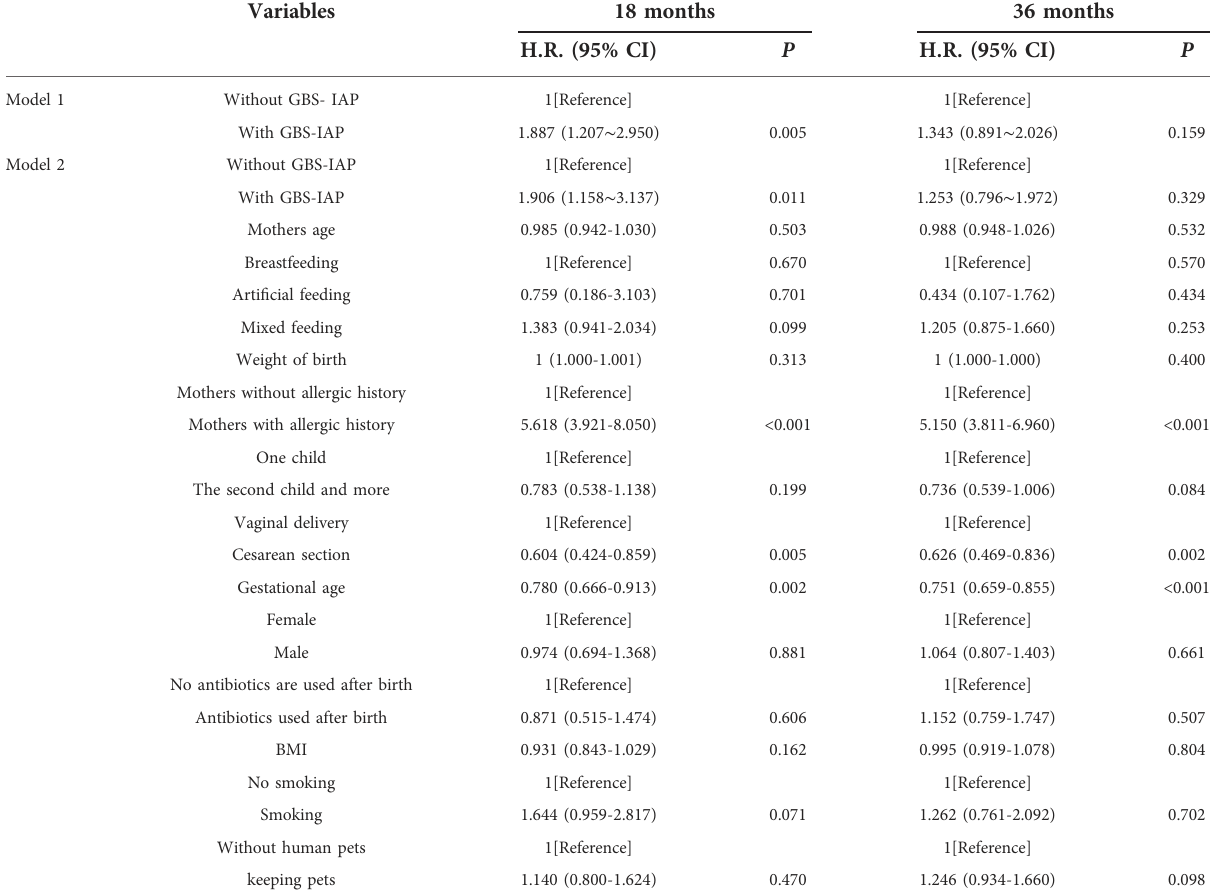
TABLE 3 Associations between intrapartum antibiotic prophylaxis (IAP) and risk of food